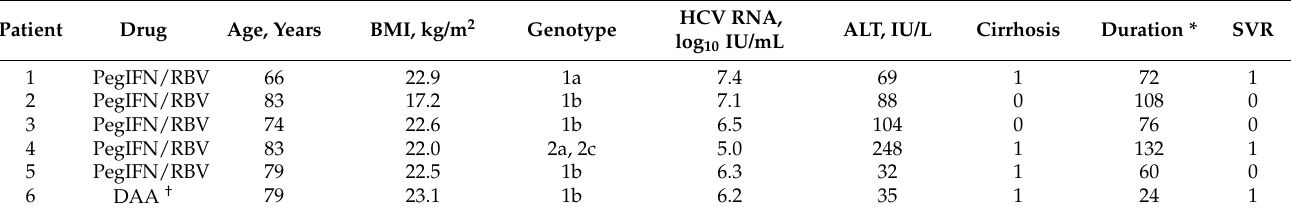
Table 2. Clinical characteristics of patients with newly developed hepatocellular carcinoma after antiviral therapy.